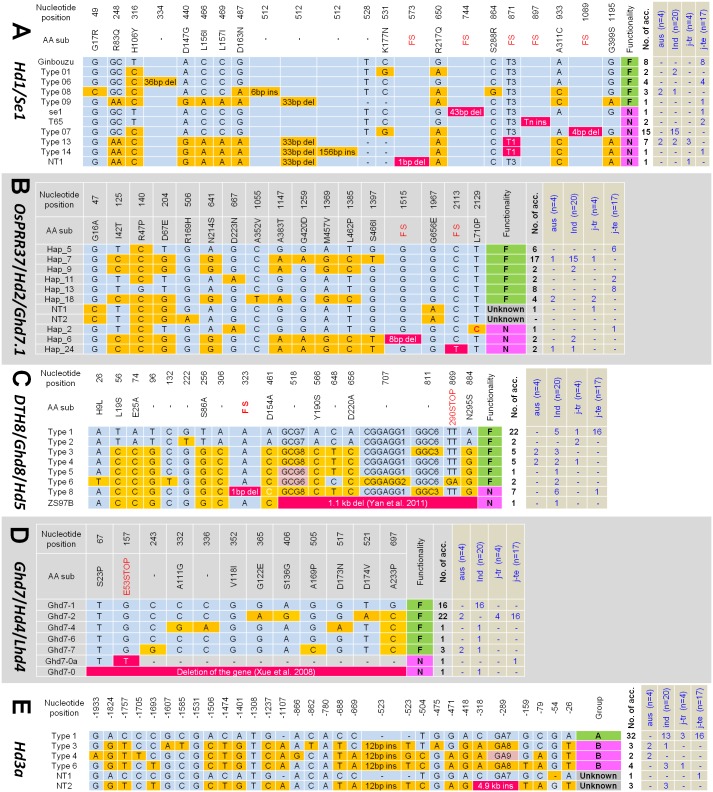
Allele types of the five major flowering genes in the 45 diverse accessions. The allele frequencies in each rice type are presented at the right panel (blue letter). The nucleotide position referred to the protein coding sequence (CDS) or promoter sequence. (A)
Hd1 alleles. Reference: Ginbouzu (GenBank Accession No. AB041840.1). (B)
OsPRR37 alleles. Reference: Nipponbare (MSU ID: Os07g49460). (C)
DTH8 alleles. Reference: Nipponbare (MSU ID: Os08g07740). (D)
Ghd7 alleles. Reference: Minghui 63 (GenBank Accession No. EU286801.1). (E)
Hd3a promoter alleles. Reference: Nipponbare (MSU ID: Os06g06320). FS, frame shift; ind, indica; j-tr, tropical japonica; j-te, temperate japonica.